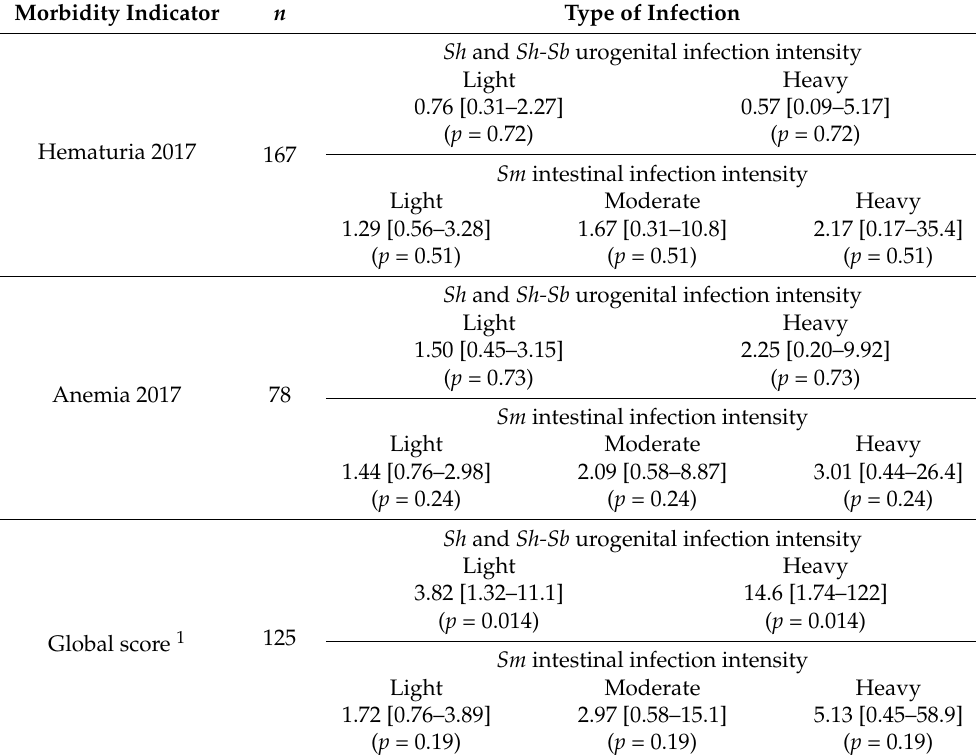
Table 6. Odds ratios (95% confidence intervals) and p -values (in parentheses) of decreased levels of morbidity in response to treatment with praziquantel among children in Senegal in 2017, depending on schistosomiasis infection intensity before treatment and adjusted for age, sex, and study site. Morbidity